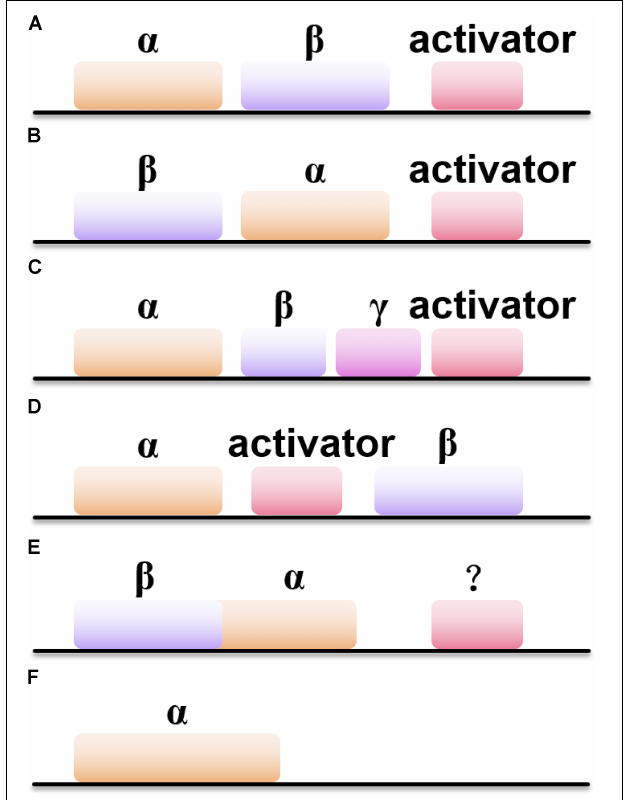
FIGURE 1 | Six types of NHases with different gene organizations. (A) The gene order of < α -subunit> < β -subunit> <activator>; (B) the gene order of < β -subunit> < α -subunit> <activator>; (C) the gene order of < α -subunit> < β -subunit> < γ -subunit> <activator>; (D) the gene order of < α -subunit> <activator> < β -subunit>; (E) the gene order of < β -subunit> < α -subunit>; (F) the gene order of solo-subunit NHase.